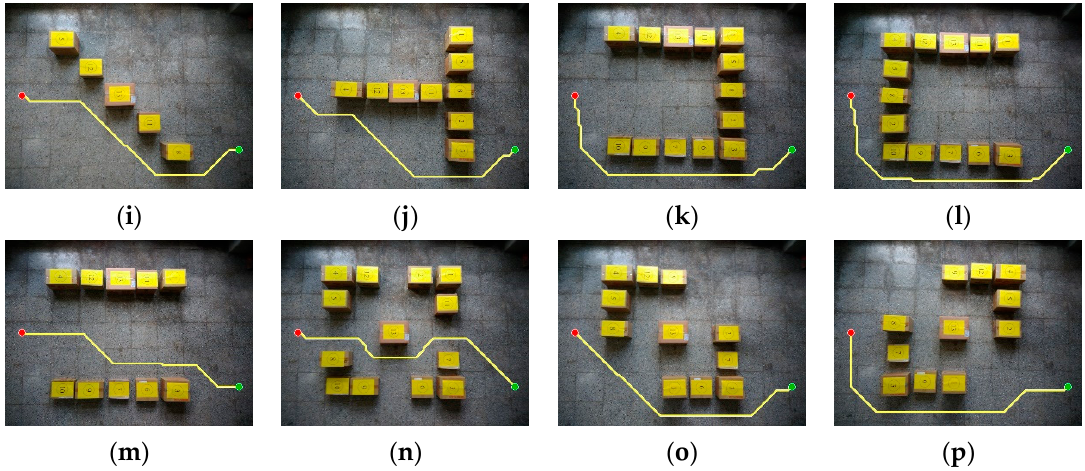
Figure 25. Planned paths shown in Experiment VI: ( a ) result #1; ( b ) result #2; ( c ) result #3; ( d ) result